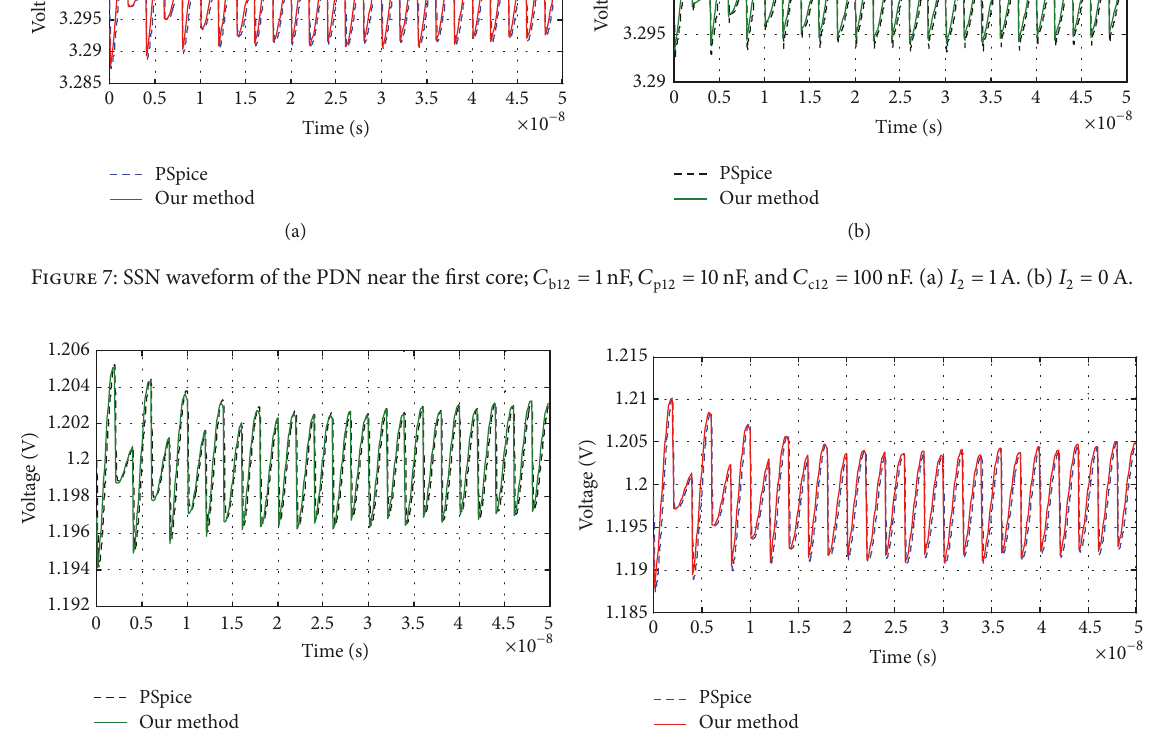
= 1nF, 𝐶 = 10nF, and 𝐶 = 100nF. (a) 𝐼 2 = 0A. (b) 𝐼 2 = 1A. b 12 p 12 c 12